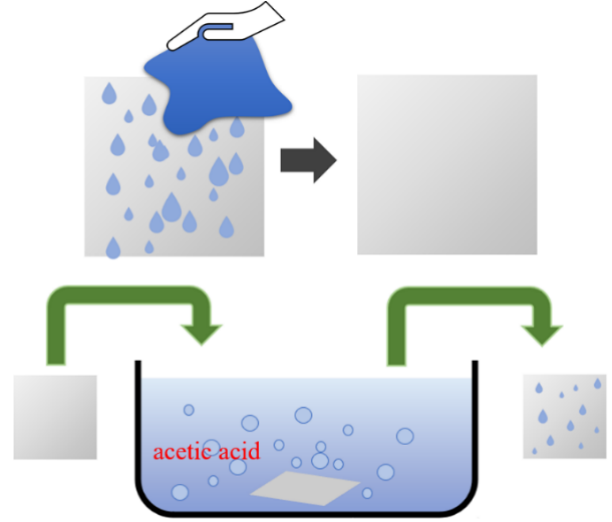
Figure 2. Cleaning the surface with ethyl alcohol and attacking the sample with acetic acid.